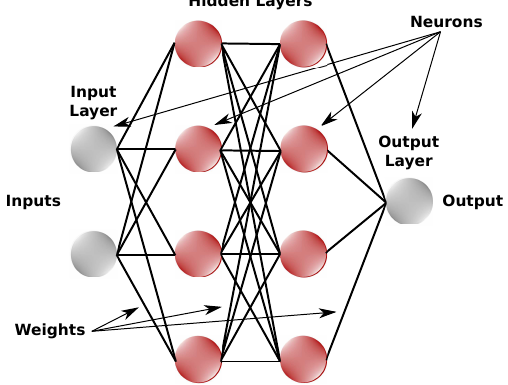
Figure 3. Example of MLP structure. Source: Adapted from Araujo